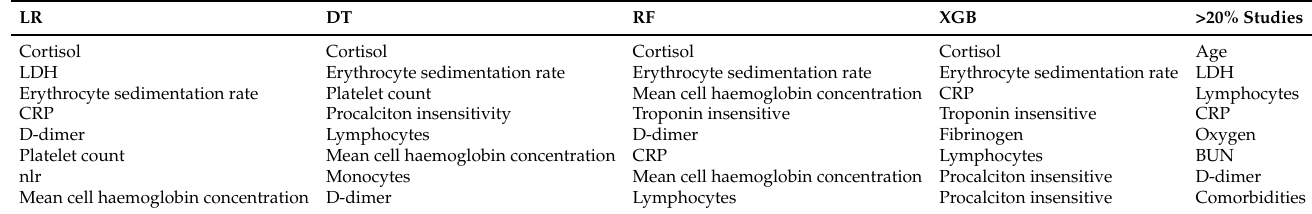
Table 7. Top important variables in COVID-19 risk